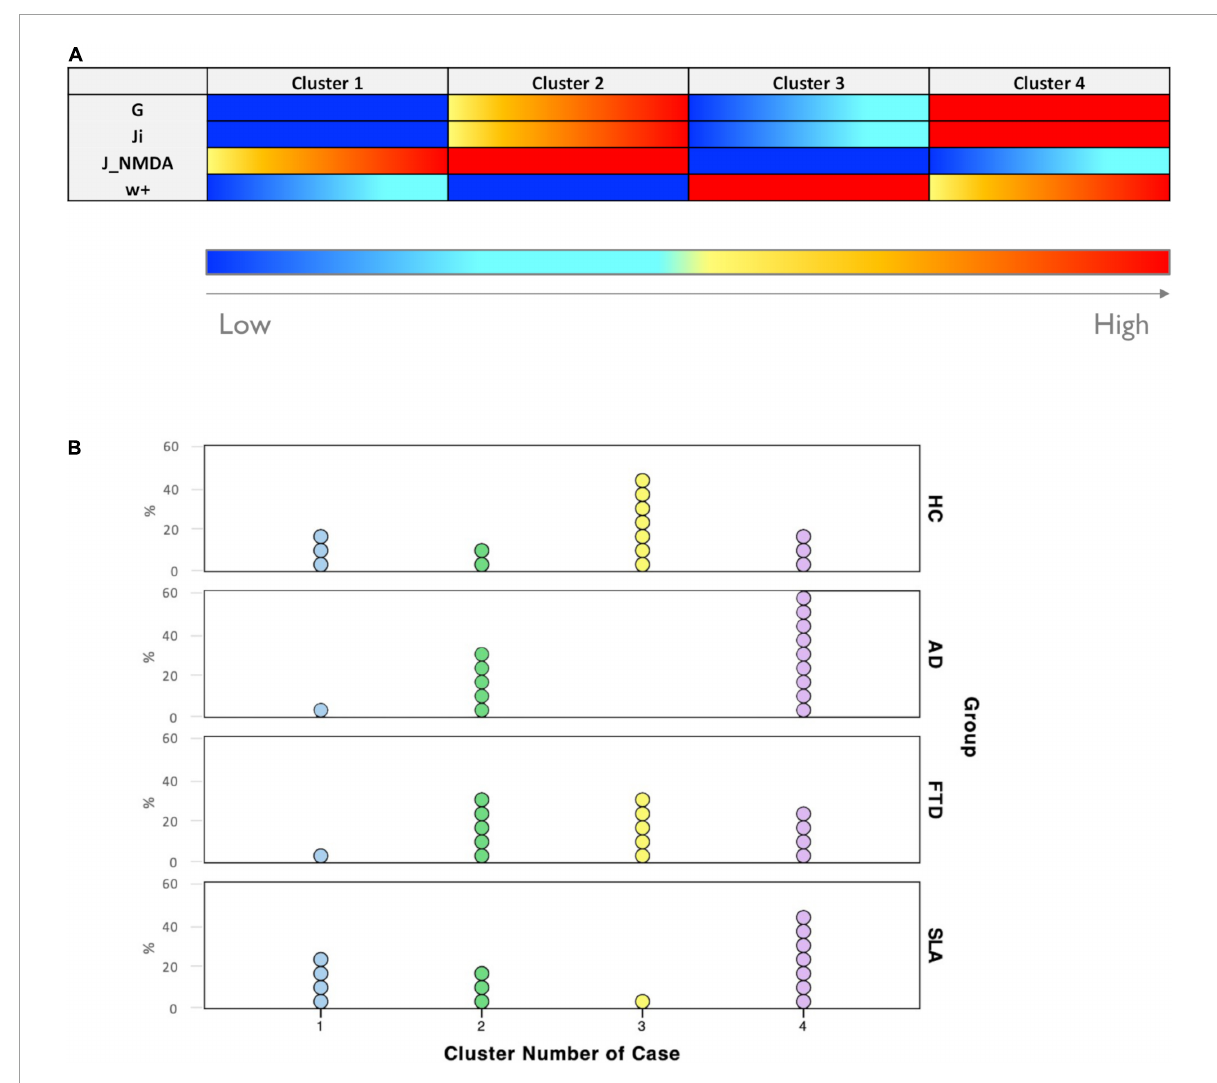
FIGURE5 Excitation/inhibition profiles. (A) Each cluster was characterized by a typical excitation/inhibition profile. The color-bar (from blue to red) represents the scale from low to high of each TVB-derived biophysical parameter. (B) Visual representation of cluster distributions across groups (Healthy Controls, Alzheimer’s Disease, Frontotemporal Dementia, and Amyotrophic Lateral Sclerosis). Cluster numbers are reported on the x -axis while cluster frequencies in each condition are reported on the y -axis. Each dot represents a single